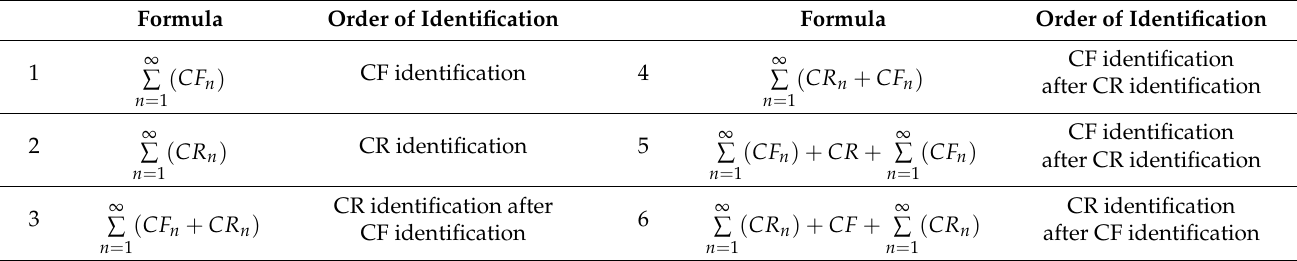
Table 3. Identification order of clause patterns in a complex sentence.